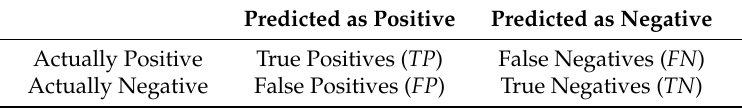
Table 1. Confusion matrix of biclass